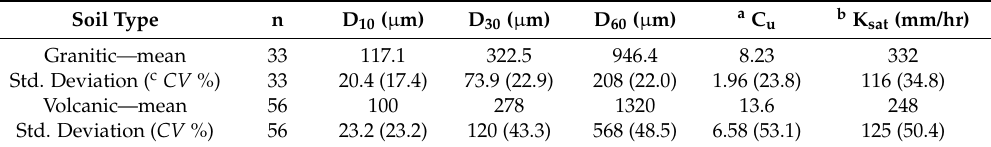
Table 2. Summary of sieved particle-size distribution measurements for the Tahoe Basin disturbed soils (>63 µ m size fraction) and estimated K sat values. From Grismer and Hogan [46].